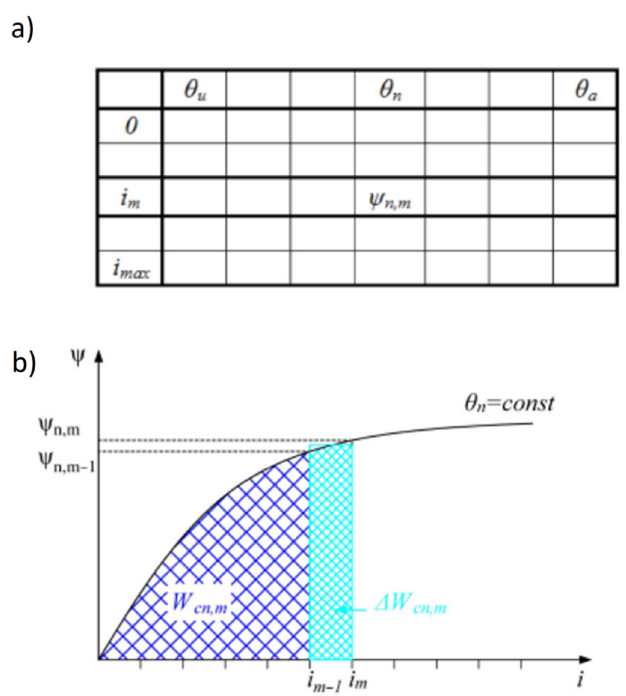
Figure 4. Model curves for flux values: ( a ) the structure of the table with recorded values of the associated flux; ( b ) the method of calculating the co-energy increase ∆ Wc ( i , θ ) from the increase of the associated flux and current at a constant rotor position θ n = const .